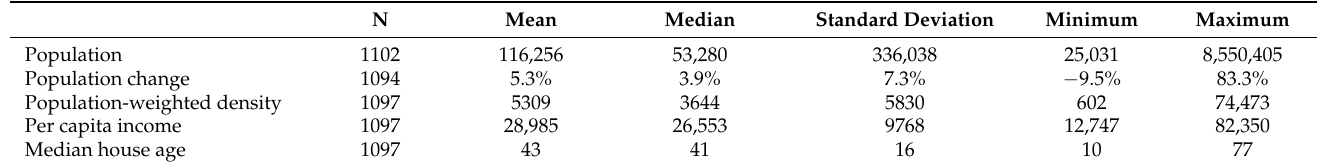
Table 2. Descriptive statistics for independent variables, cities with population greater than